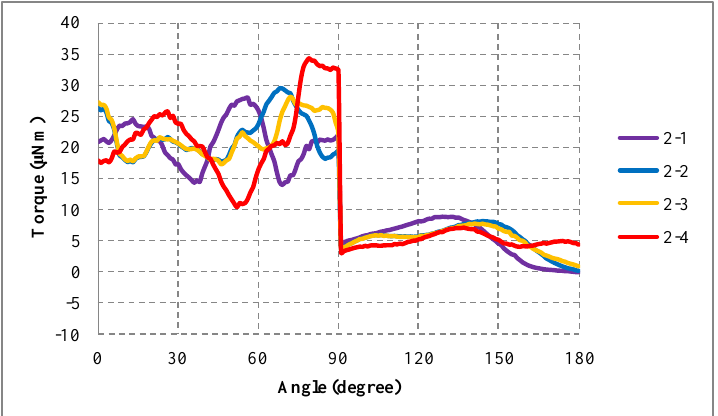
Figure 5. Step 2: Design process of the rotor magnetic pole of quadrants 1 and 3.